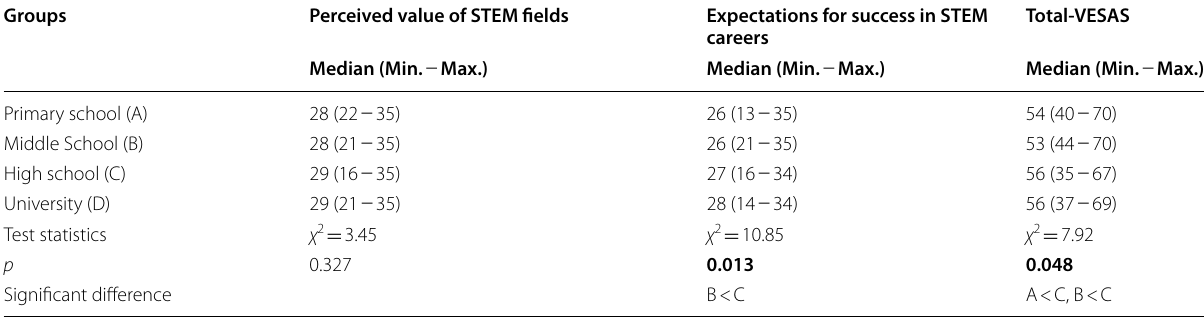
Table 6 The results of Kruskal − Wallis test for participants’ STEM motivation scores according to their fathers’ educational levels